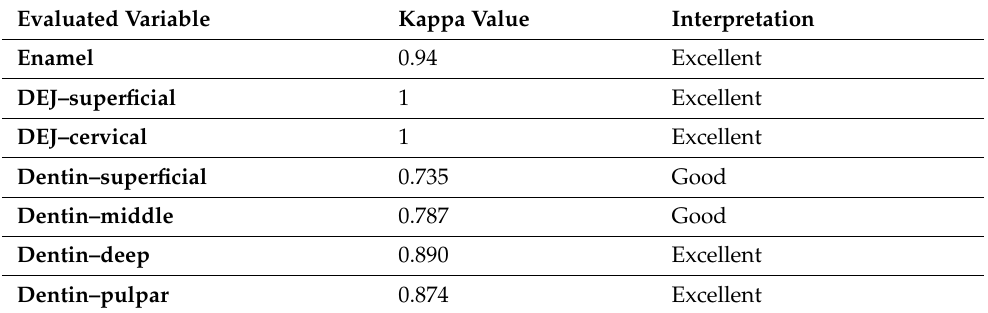
Table 4. Results of the Kappa–Cohen coefficient for the intra-operator